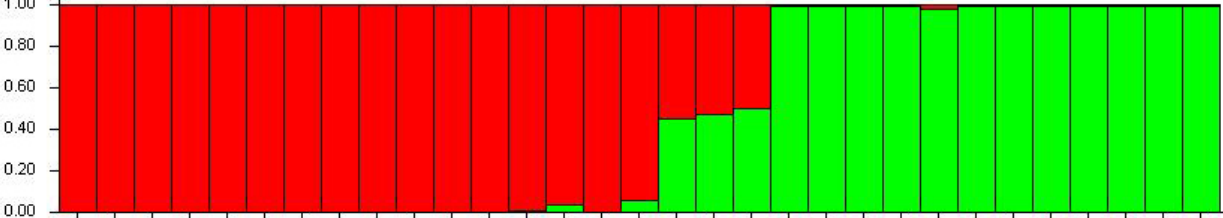
Figure 3. Population structure of sesame accessions. STRUCTURE was constructed by all loci. K = 2. Clusters are indicated by different colours. Samples included in all clusters are listed in Table